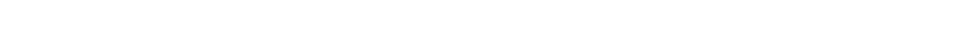
Frontiers in Endocrinology | Bone